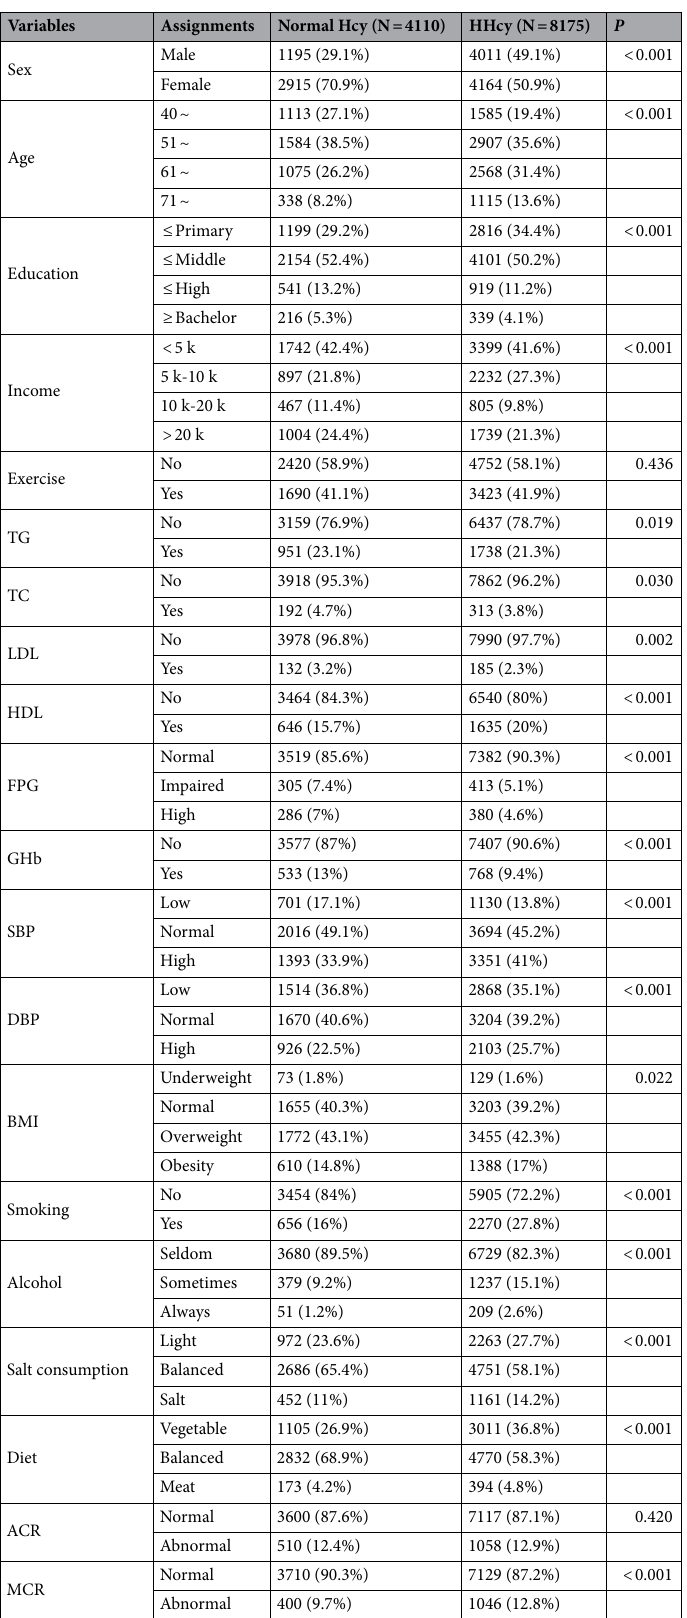
Table 1. Baseline characteristics and clinical parameters between two